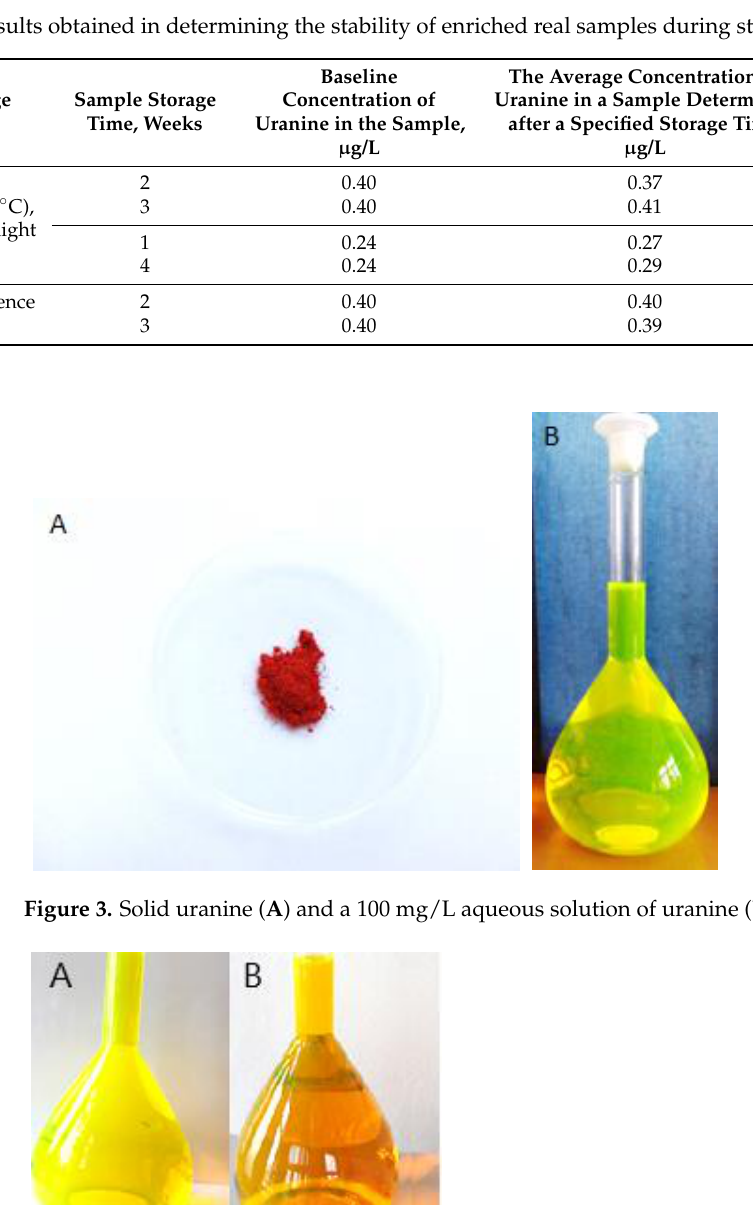
Figure 4. Change in color of uranine solution under the influence of light. Figure left — freshly prepared aqueous solution of uranine with a concentration of 100 mg/L ( A ), and the same solution exposed to light for 7 days ( B ) (photo: M. Gajec).